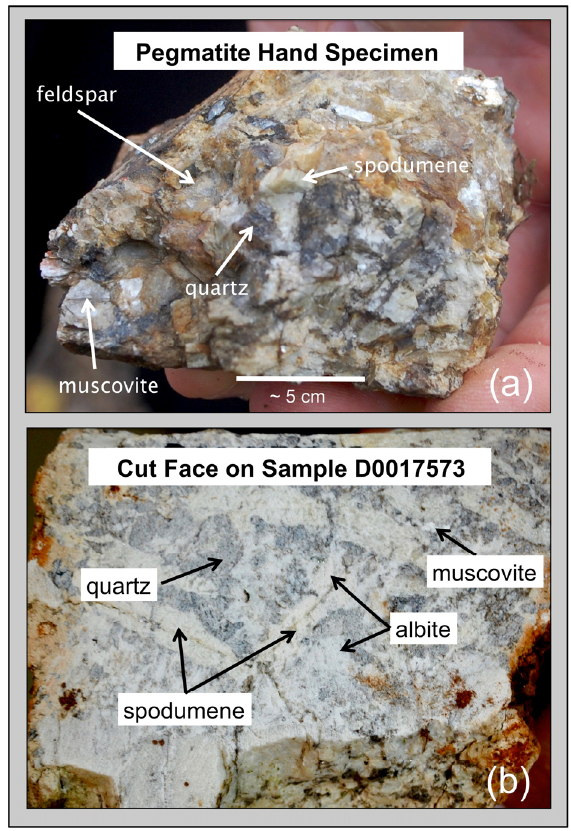
Figure 2. Two samples from the CLP in Gaston County, North Carolina: ( a ) hand specimen showing the typical mineralogy of spodumene, feldspar, quartz, and muscovite; ( b ) slab face of outcrop sample D0017573 showing a mineralogy of spodumene, quartz, albite, and muscovite.